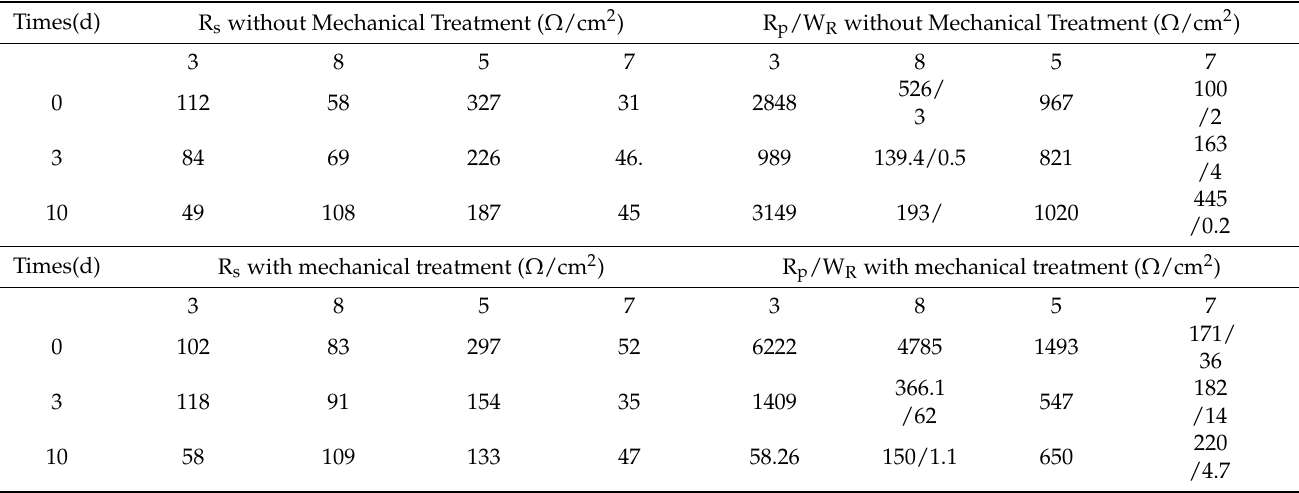
Table 3. Fitting results of R s , R p , and W R by